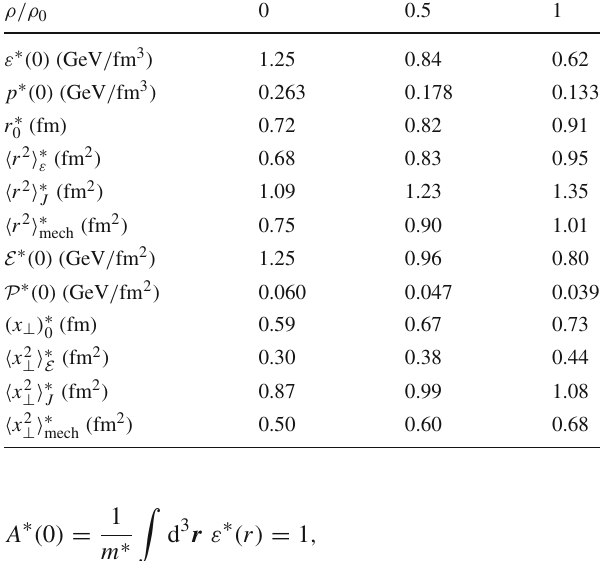
Table 1 Various quantities related to the GFFs of the nucleon in both the BF and IMF: the energy distributions at the center (ε ∗ ( 0 ), E ∗ ( 0 )) , the pressure distributions at the center ( p ∗ ( 0 ), P ∗ ( 0 )) , nodal points , ( x ∗ ) )) and the mean square radii of the mass, of the pressures ( r ∗ 0 ⊥ 0 angular momentum and mechanical ( (cid:3) r 2 (cid:4) ∗ , (cid:3) x 2 ⊥ (cid:4) ∗ ) at different